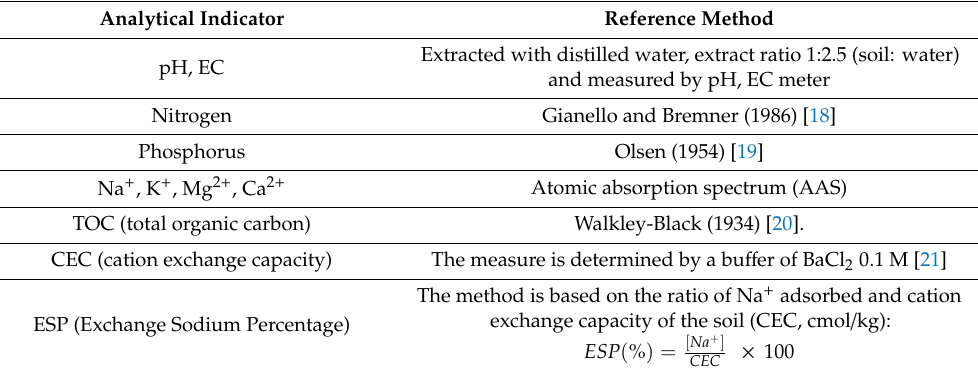
Table 2. Methods of analyzing parameters in the soil environment.